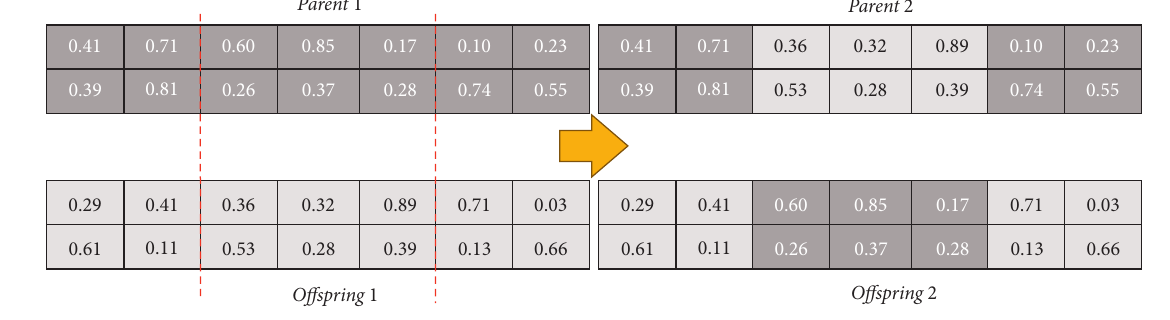
Figure 6: Example of crossover Table 1: Parameters and their level in GA.